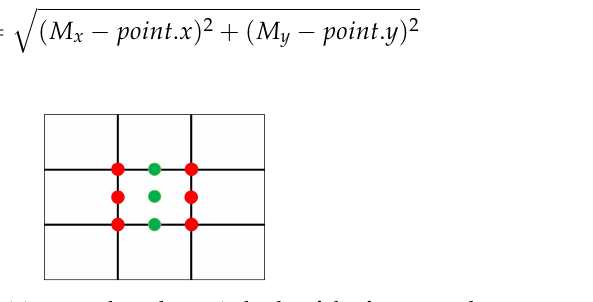
Figure 9. The positions to place the main body of the foreground.